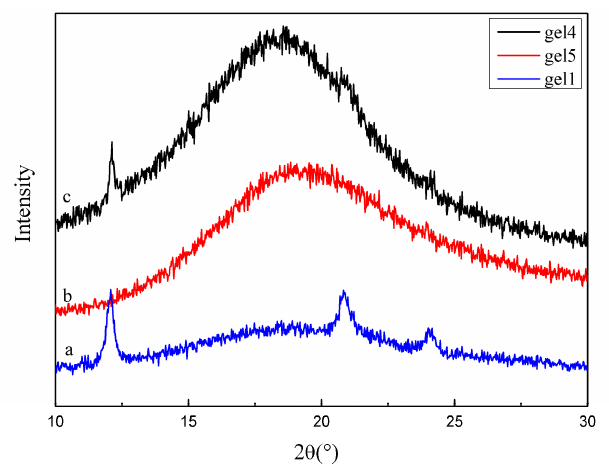
Figure 2. The wide-angle X-ray diffraction profile for ( a ) physical crosslinked hydrogels, ( b ) chemical crosslinked hydrogels, and ( c ) double-crosslinked hydrogels.